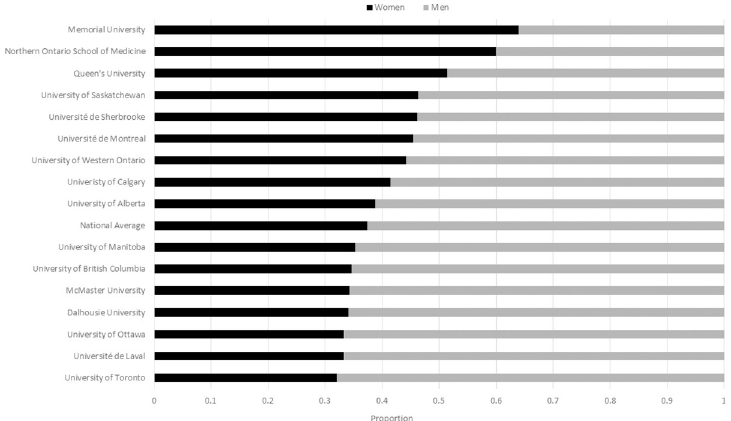
Fig 9. Proportion of women to men surgical residents by university. Ordered from highest proportion of women surgeons to lowest proportion. Significant differences exist between universities (p < 0.01).